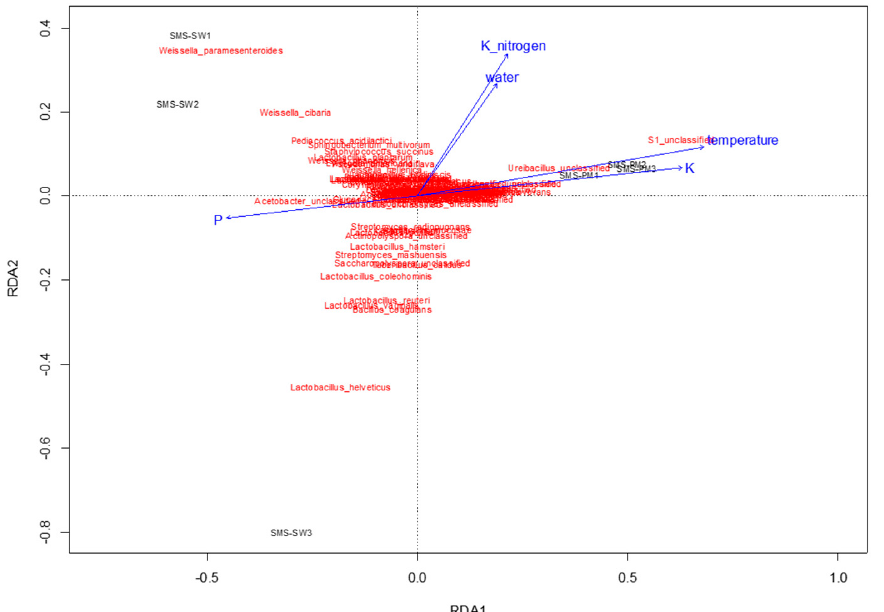
Figure 5. Redundancy analysis assessing the relationship between environmental factors (blue arrows) and bacterial communities (red). The arrows indicate the size and direction of the coefficients of physiochemical variables in the linear model.